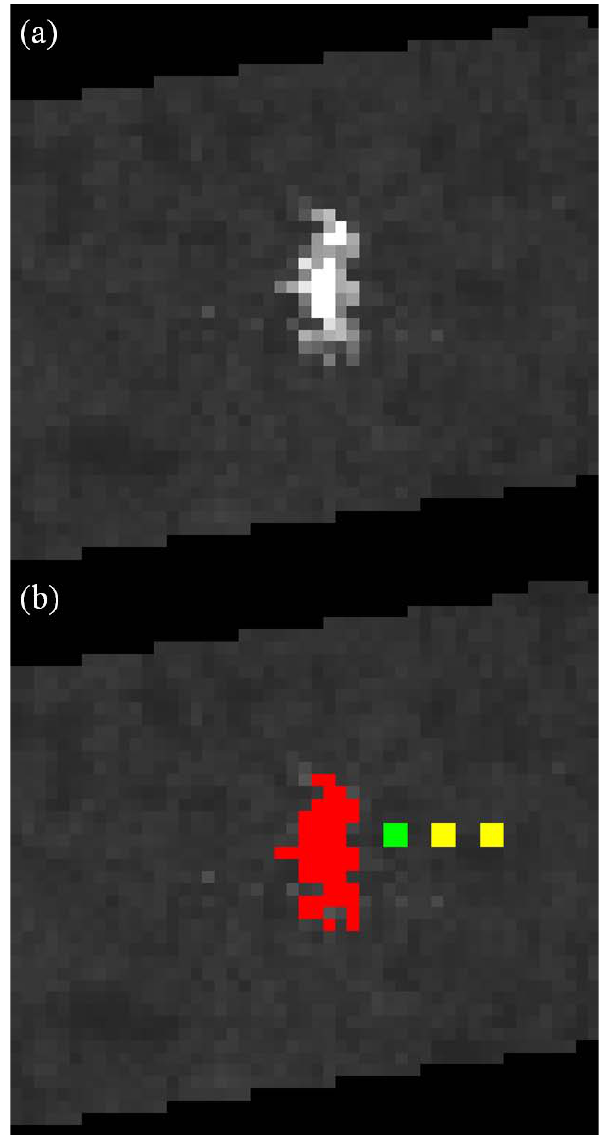
Fig. 2. (a) VIIRS nighttime imagery over Alta Floresta for 3 Au- gust 2012. (b) Similar to Fig. 2a with artificial city light sources highlighted in red (collection of the brightest pixels from a man- ually selected box of pixels covering the city), manually selected background pixels highlighted in green, and additional background pixels highlighted in yellow.